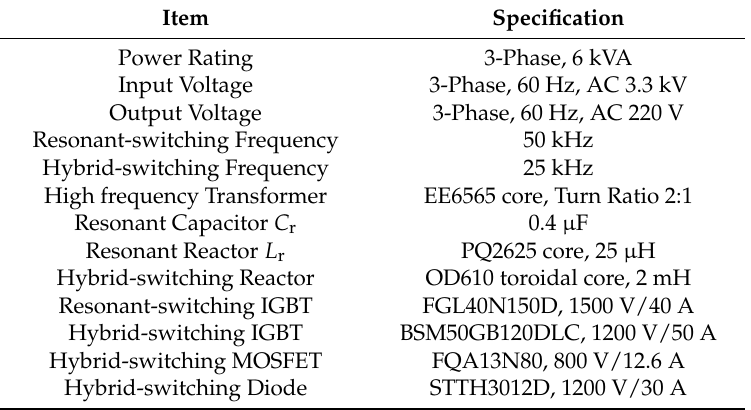
Table 1. Specification of bidirectional intelligent semiconductor transformer.